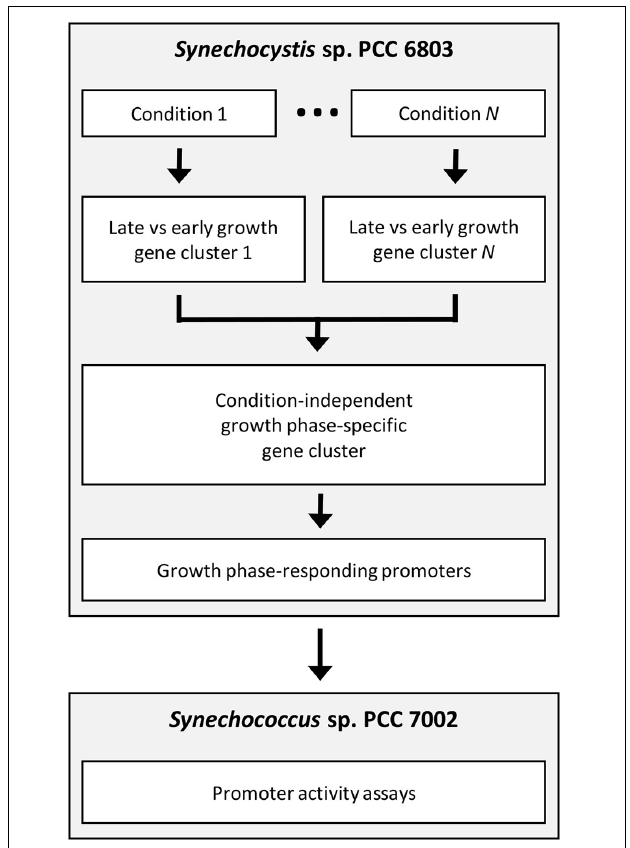
FIGURE 1 | Workflow for the identification and characterisation of growth phase-specific promoters. Synechocystis sp. PCC 6803 was cultivated in numerous different conditions. RNA sequencing of samples harvested during early and late growth phases led to the identification of condition-independent, growth phase-specific genes and candidate promoters. Heterologous promoter behaviour was characterised using a green fluorescent protein (GFP)-based assay in Synechococcus sp. PCC